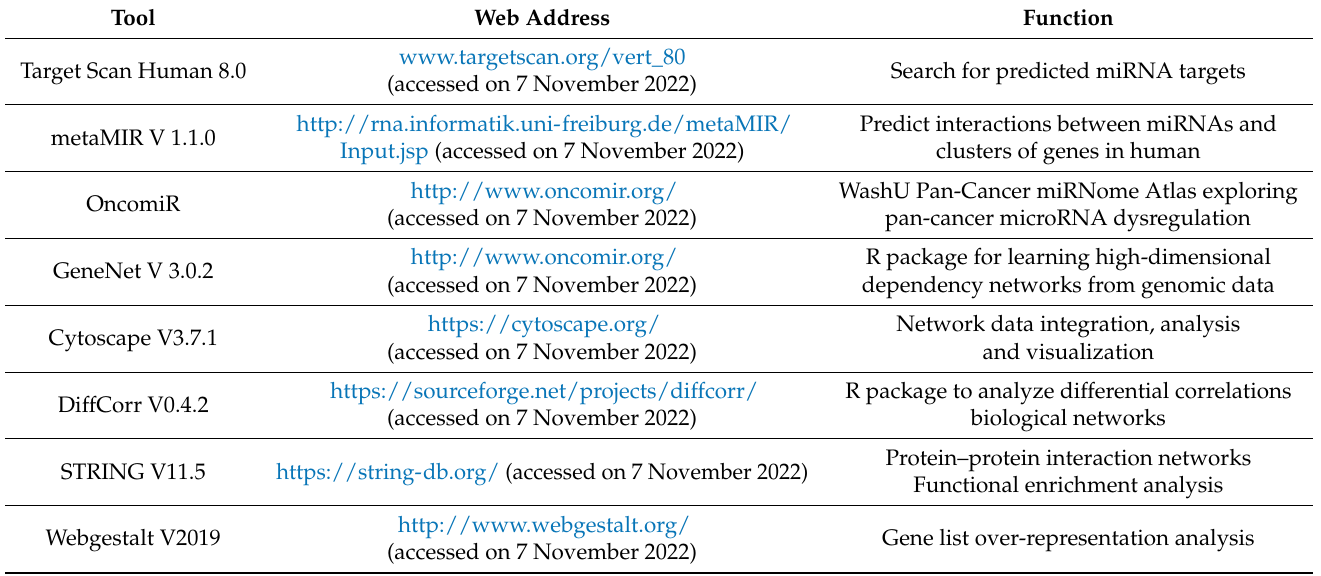
Table 2. A list of publicly available bioinformatics software used to identify candidate miRNAs and their gene targets, with particular relevance to ovarian